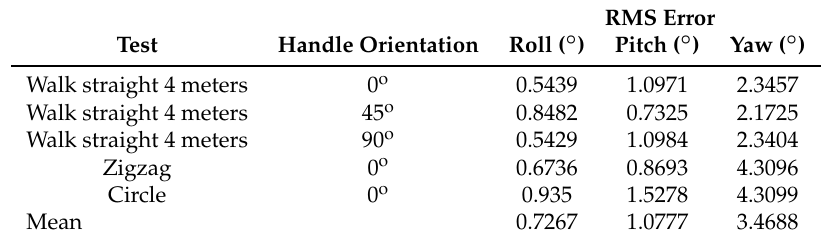
Table 3. X-Sens Euler angles estimation error.